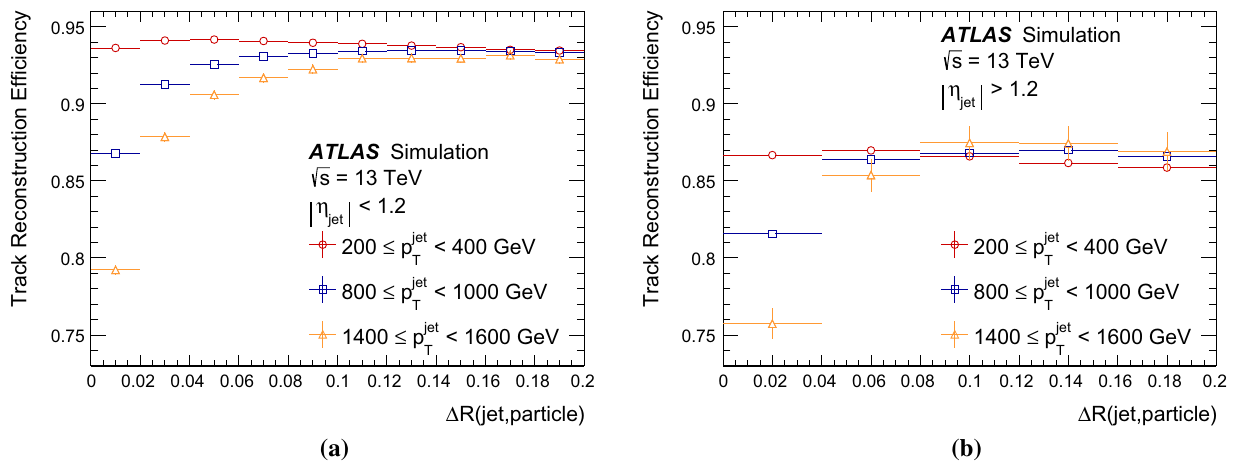
Fig. 13 The efficiency to reconstruct charged primary particles in jets with a | η | < 1 . 2 and b | η | > 1 . 2 is shown as a function of the angular distance of the particle from the jet axis for various jet p T for simulated dijet MC